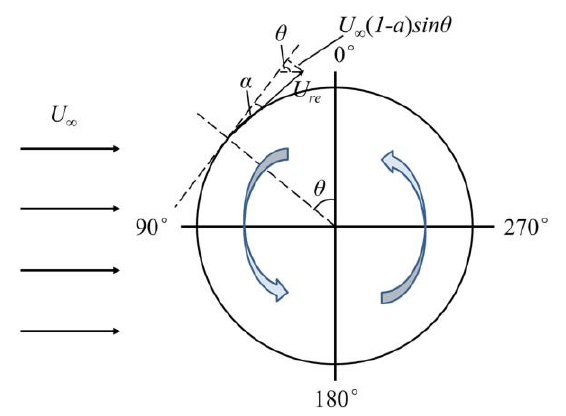
Figure 13. Geometrical relationship between angle of attack and blade azimuth. θ is the azimuthal angle, α is the angle of attack, a is the axial induction factor.